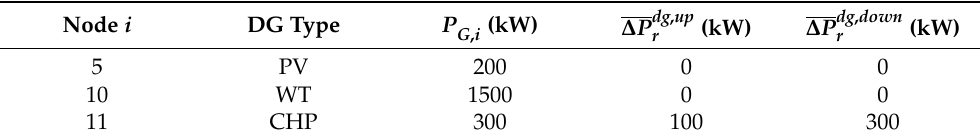
Table 2. DG unit